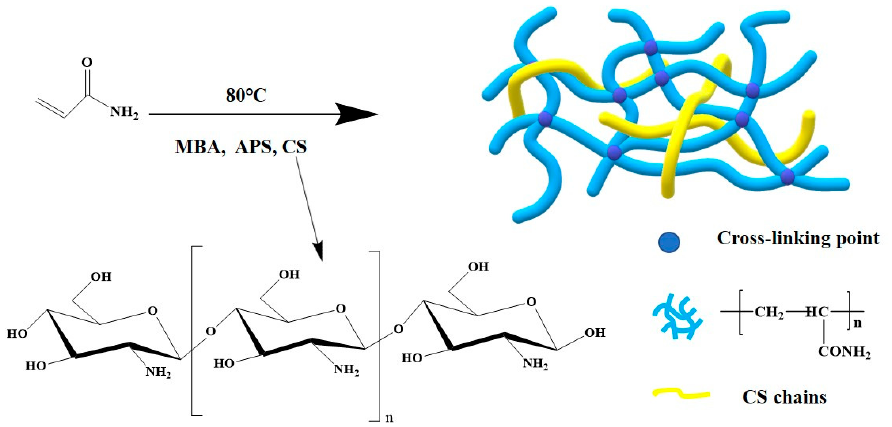
Figure 1. Preparation process of PAMC gel. Table 1. Specific ratios and properties of PAMC hydrogel.